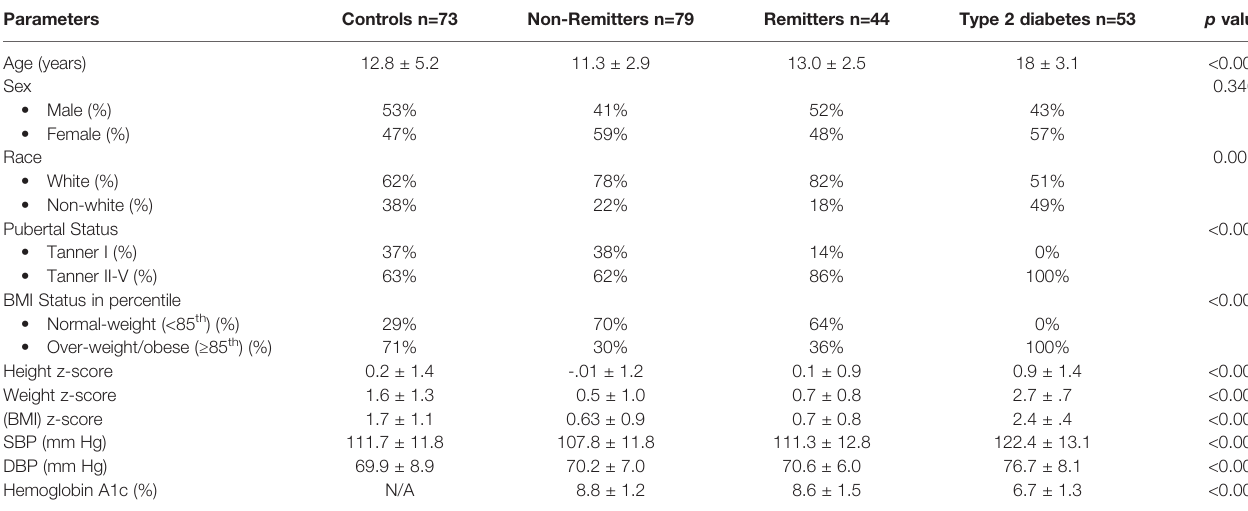
TABLE 1 | Anthropometric and biochemical characteristics of the subjects (47).